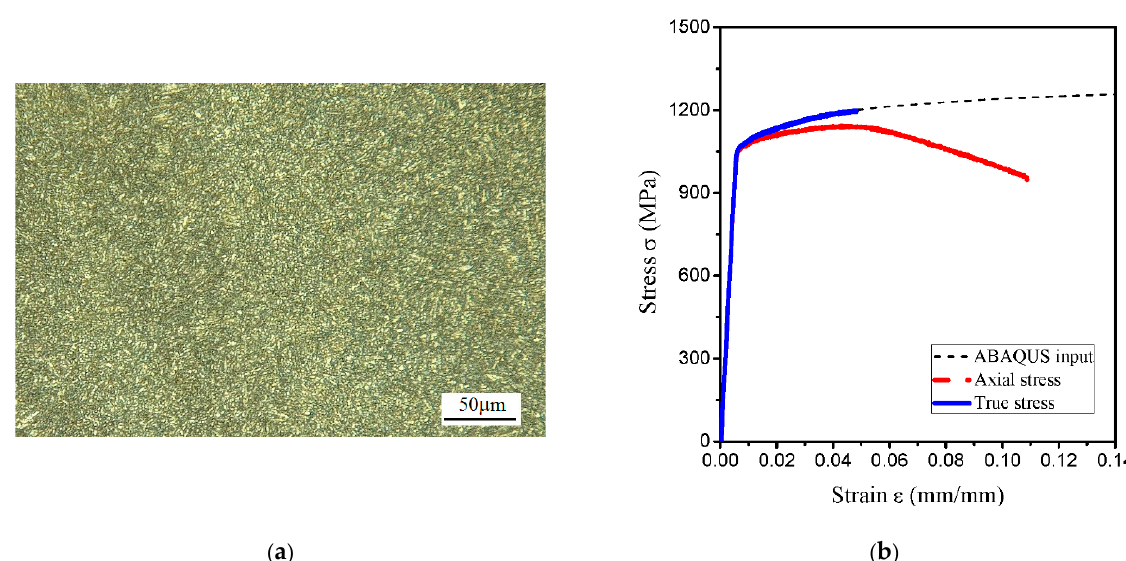
Table 1. Chemical composition of the 30CrMo steel (wt.%).